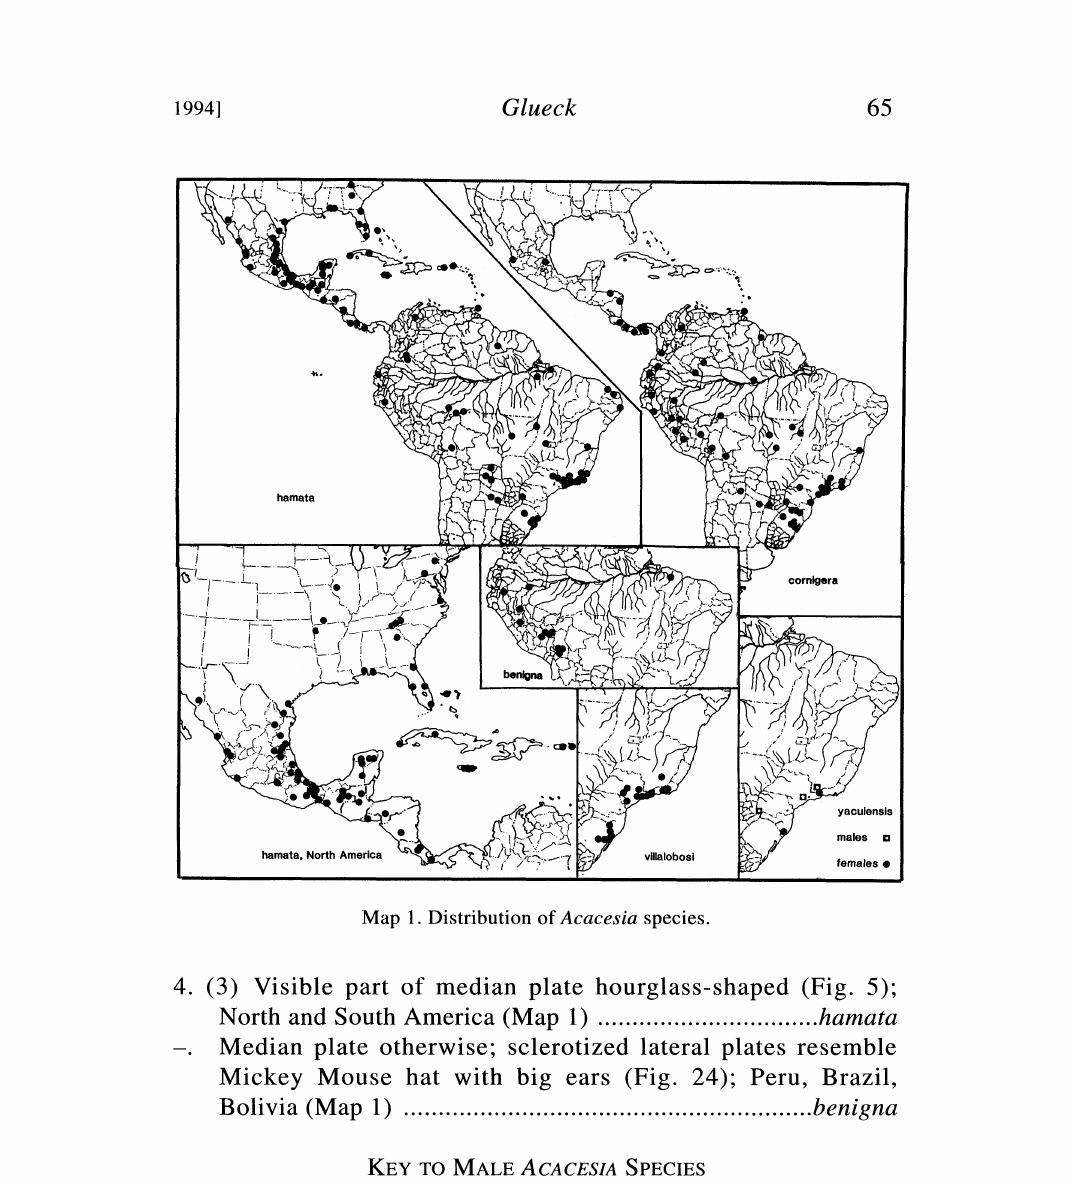
Map 1. Distribution of Acacesia